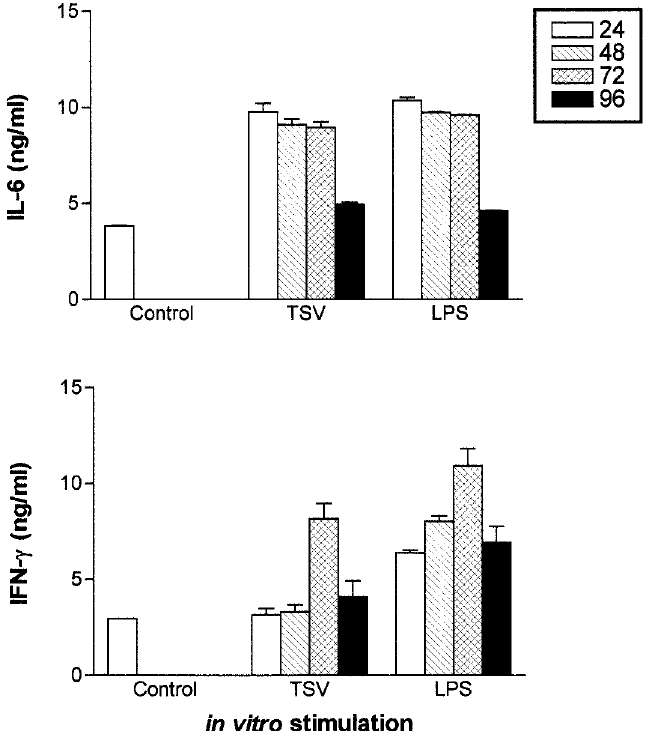
FIG. 5. Comparision of cytokine released after TSV or LPS stimulation. Groups of mice were sacrificed and their peritoneal macrophages were collected. Peritoneal macrophages were stimulated in vitro with 55 m g/ml of TSV or 5 m g/ml of LPS and, after different time intervals, the supernatants were collected. IL-6 and IFN- g were assayed as described in Fig. 2. Each point represents the mean value of samples from five experiments ± standard deviation in different groups of five